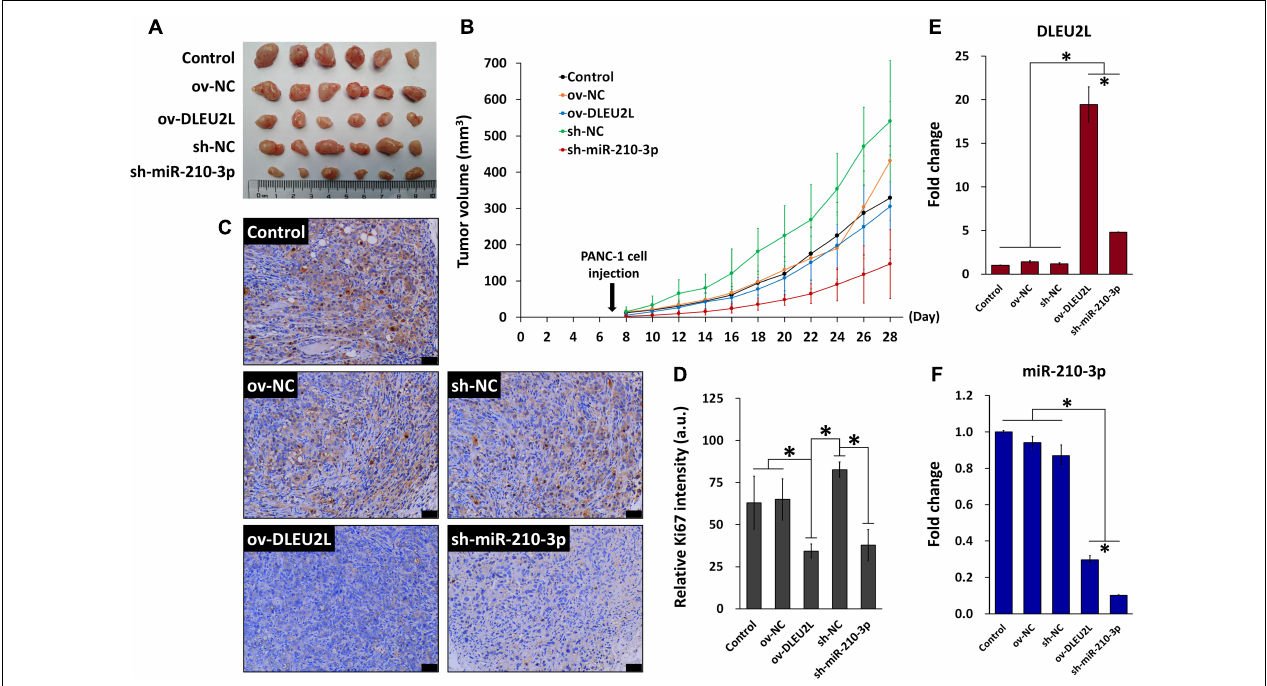
FIGURE 6 | In vivo model of pancreatic tumor incorporating DLEU2L overexpression or miR-210-3p interference. (A) Xenografted pancreatic tumors extracted from mice on day 28 of tumor growth. (B) Tumor volume during the 28-day tumor growth period. Tumor volume was calculated using the formula volume = long diameter × (short diameter) 2 × 0.5. (C) Ki-67 staining of tumor tissues. Brown staining indicates proliferating tumor cells. Scale bar, 50 µ m. (D) Quantification of the intensity of Ki-67 staining. qRT-PCR of the expression of (E) DLEU2L and (F) miR-210-3p in tumor tissues. All numerical data are expressed as the mean ± SD ( n = 3); ∗ p < 0.05. Statistical analysis was carried out using